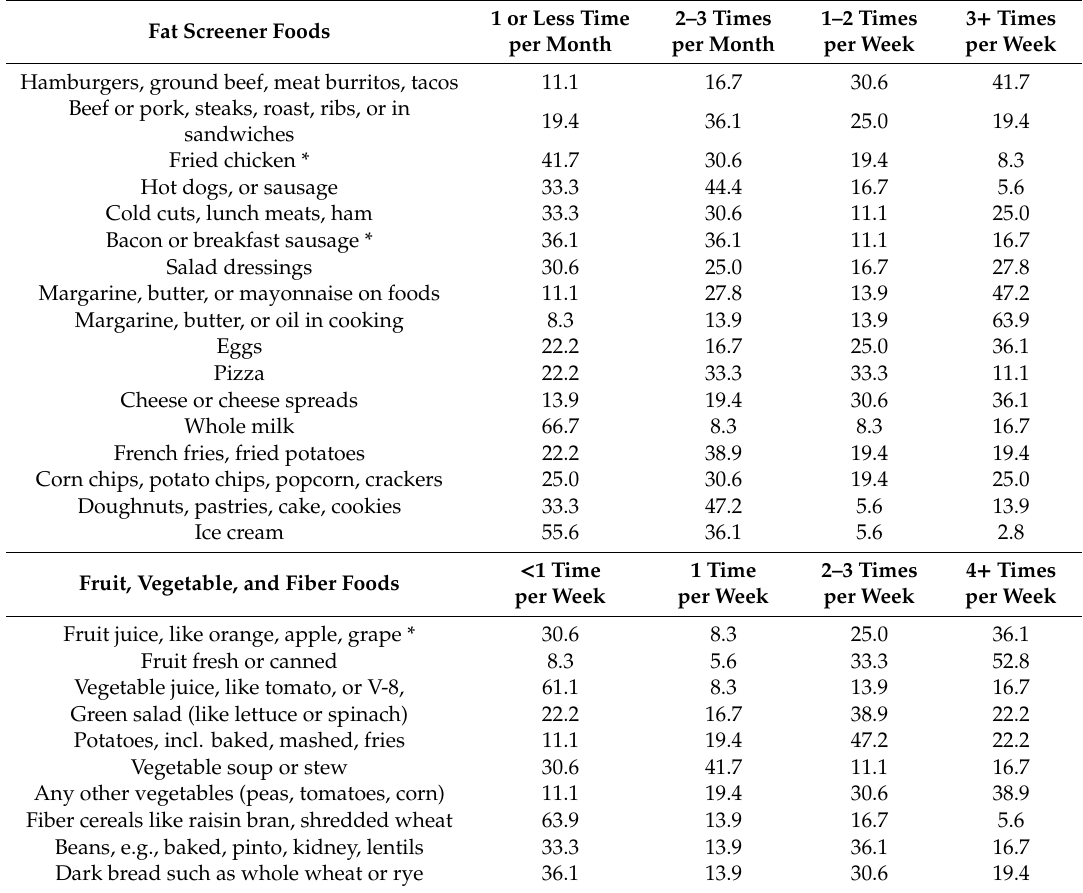
Table 4. Consumption frequency of individual food items from the Food Frequency Dietary Screeners by low-income Iowa women ( n = 36; * significant di ff erence by